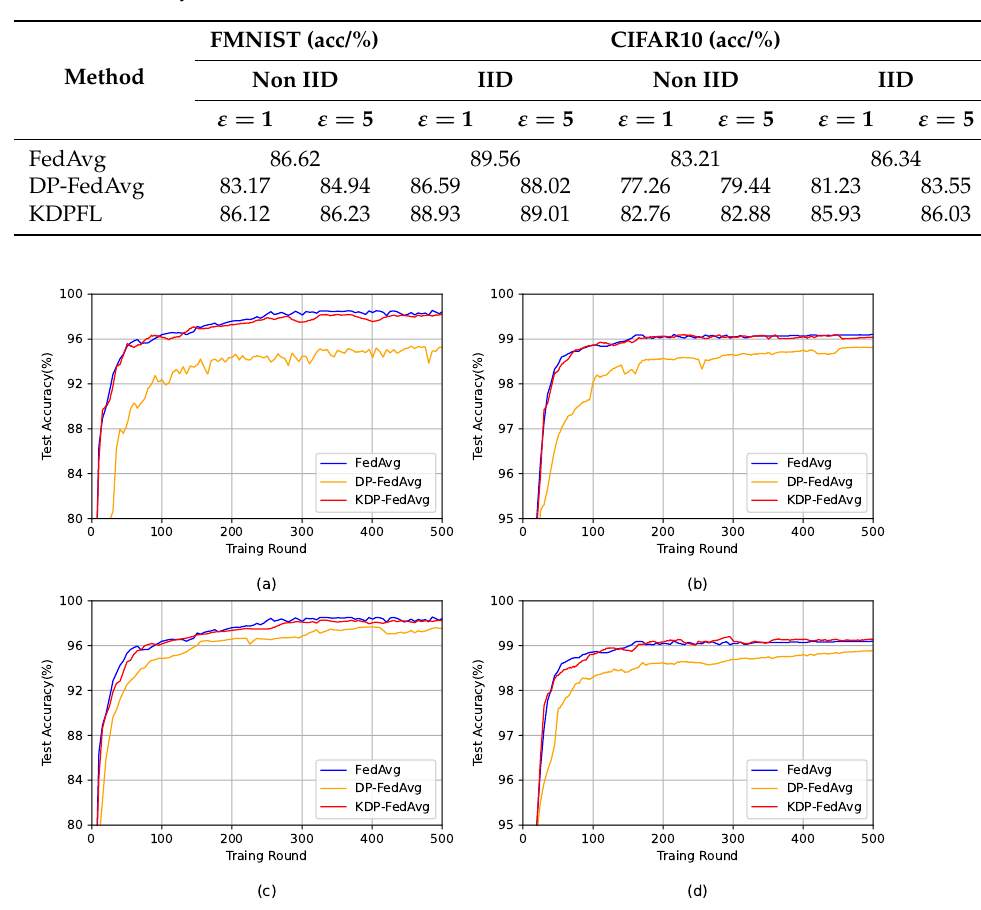
Table 4. Accuracy in different models and datasets.